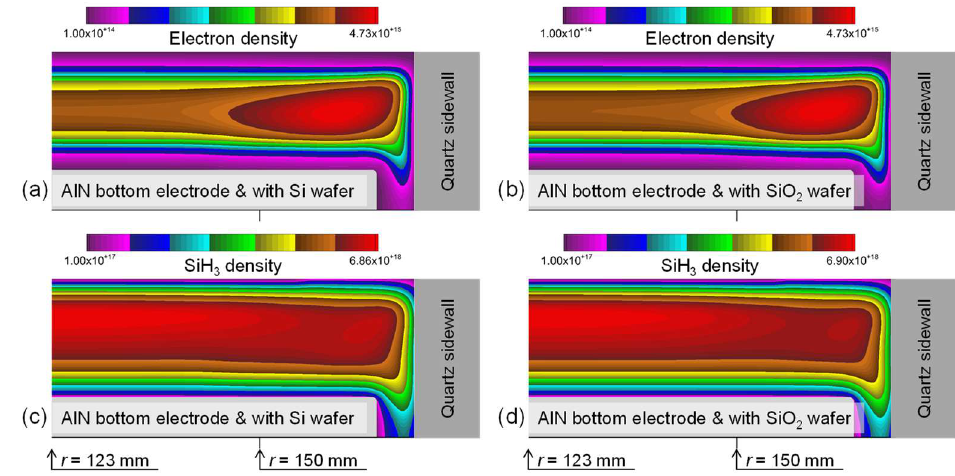
Figure 4. Effects of the dielectric constant of the wafer on the spatial distribution of the plasma parameters. Contour plots for the spatial profiles of the time-averaged electron density (m − 3 ) for ( a ) Case 4 and ( b ) Case 5 for r ≥ 123 mm. Contour plots for the spatial profiles of the time-averaged SiH 3 density (m − 3 ) ( c ) for Case 4 and ( d ) for Case 5 for r ≥ 123 mm. The profiles are radially uniform for r < 123